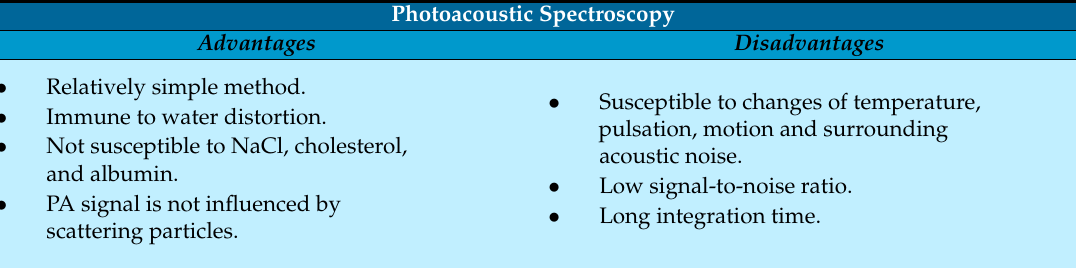
Table 16. Advantages and disadvantages of photoacoustic